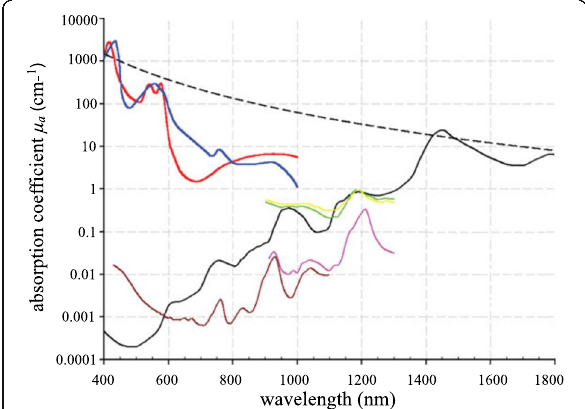
Fig. 2 Absorption spectra of endogenous tissue chromophores [54]. Oxyhemoglobin: red line; Deoxyhemoglobin: blue line; Water: black line; Lipid a : brown line; Lipid b : pink line; Melanin: black dotted line; Collagen: green line; Elastin: yellow